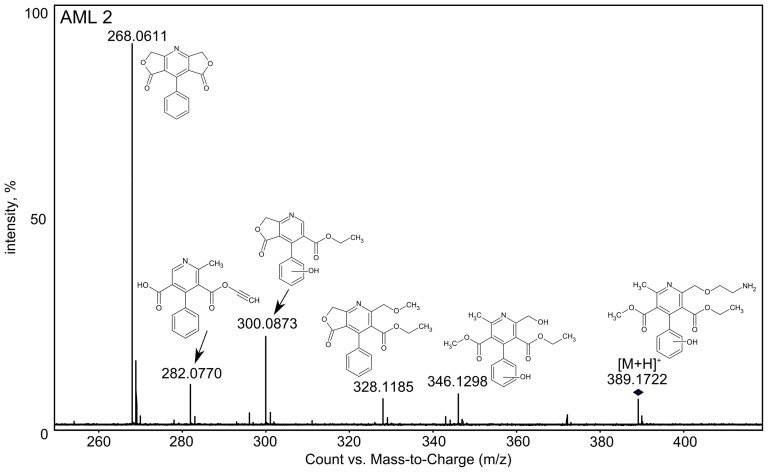
MS/MS spectrum of AML 2 with proposed structures of each fragment ion.